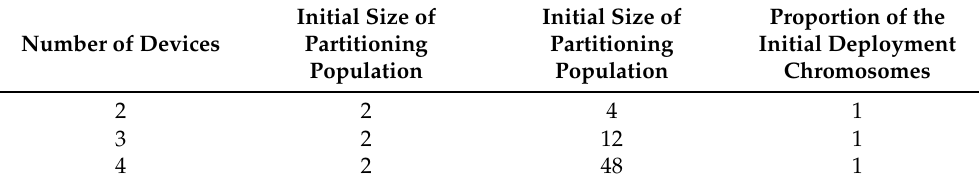
Table 7. The initial partitioning and deployment chromosome population size in experiments on B-ResNet.